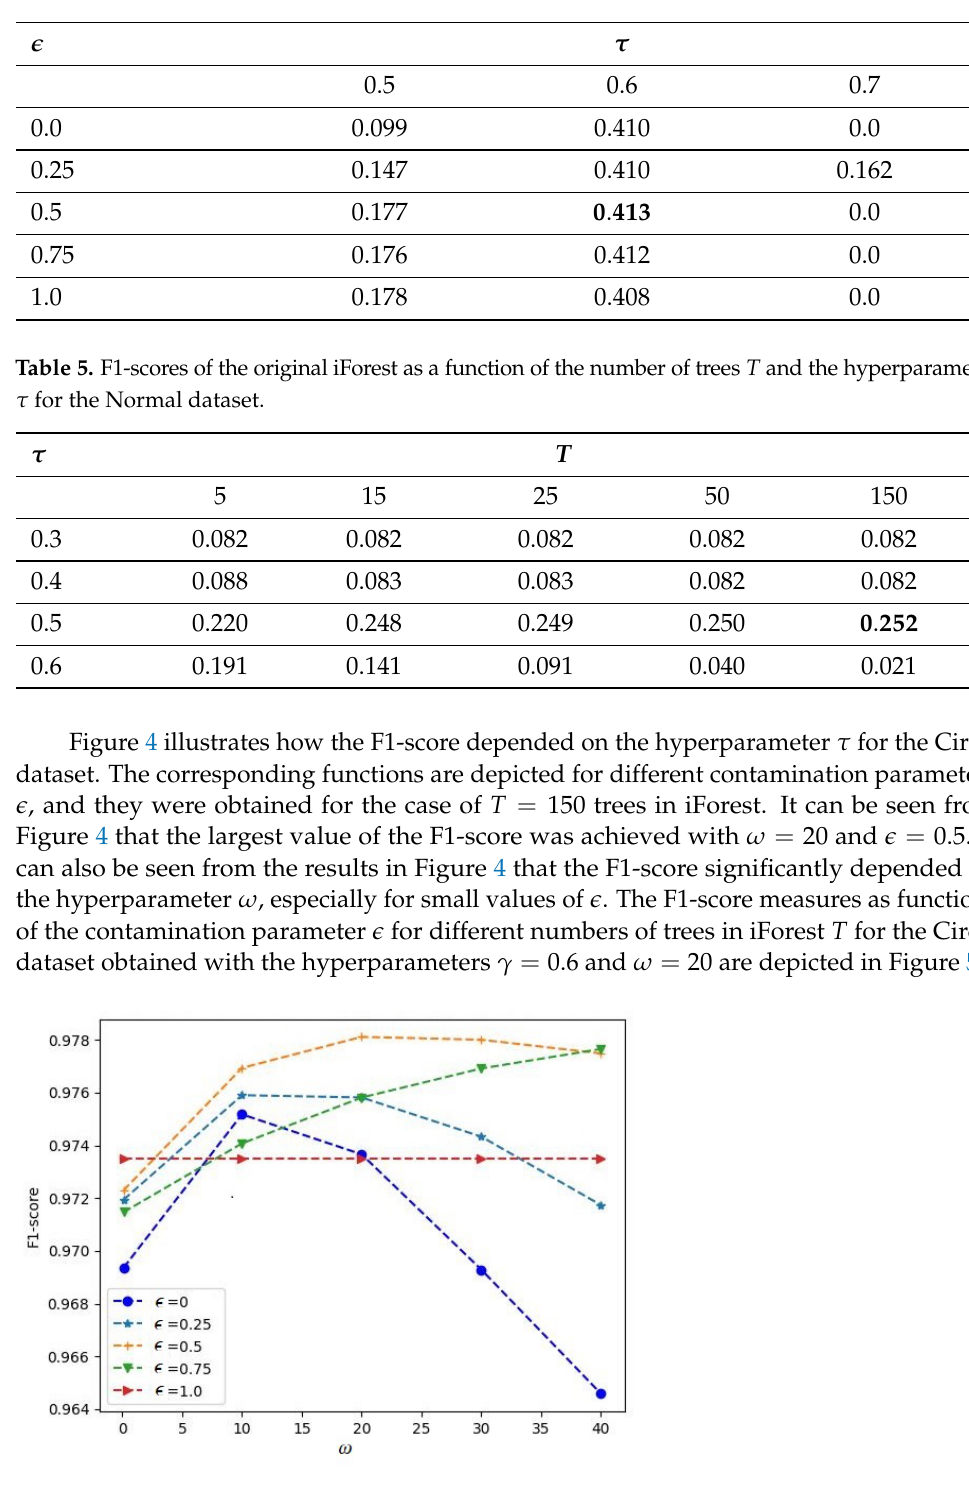
Figure 4. F1-score measures as functions of the softmax hyperparameter ω for different contamination parameters (cid:101) for the Circle